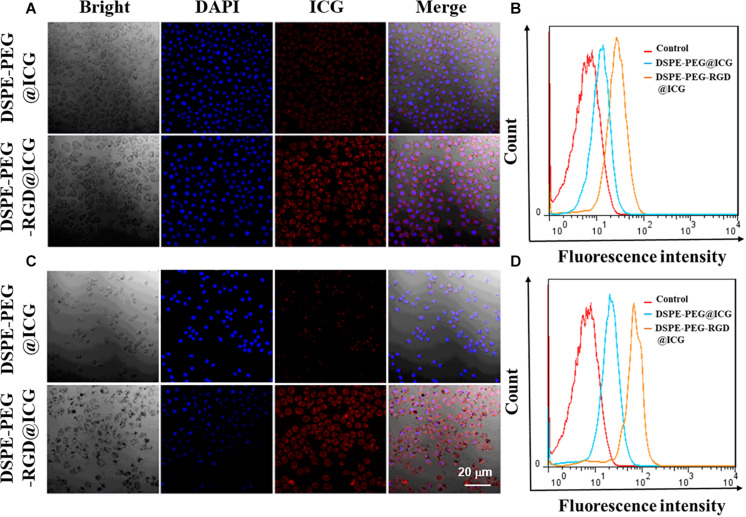
Confocal images and flow cytometry analysis of DSPE-PEG@ICG or DSPE-PEG-RGD@ICG by SGC7901 cells at 4 h (A, B) and 12 h (C, D), respectively.